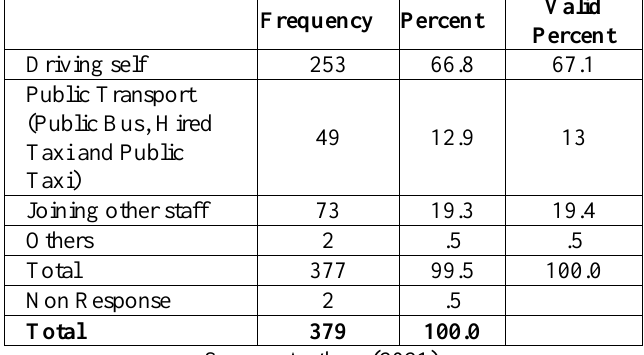
Table 2: Regular means of transportation of respondentes. Table 3: Reason for choice of regular travel mode of